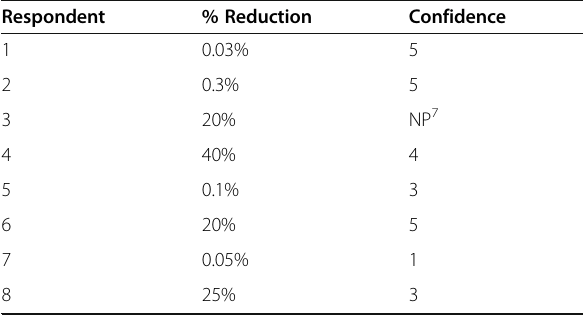
Table 7 Relevant question from the survey and responses 3. a) What is your estimate of the reduction in the potential of humanity from catastrophes that reduce global agricultural output by 10% suddenly (e.g. regional nuclear war like between India and Pakistan, or a volcanic eruption like the one that caused the year without a summer in 1816) (if there had been no